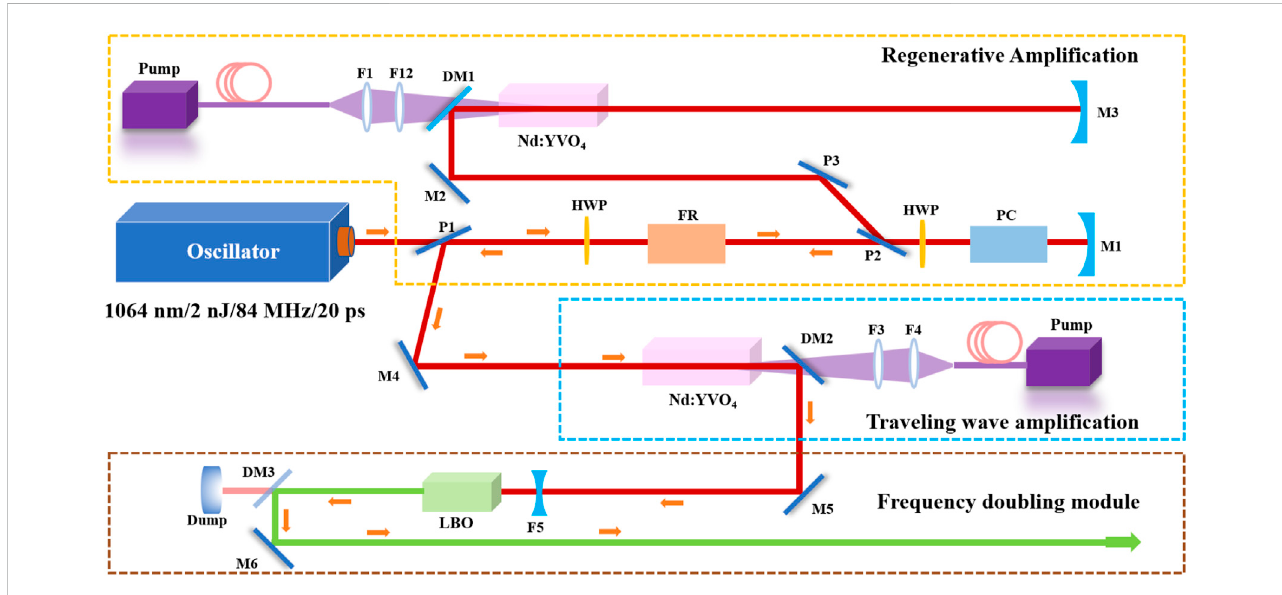
FIGURE 1 Schematic showing the layout of the laser system. PC, BBO crystal Pockels cell; HWP, half-wave plate; FR, Faraday rotator; M, mirrors; F, focus lens; P, Brewster angle